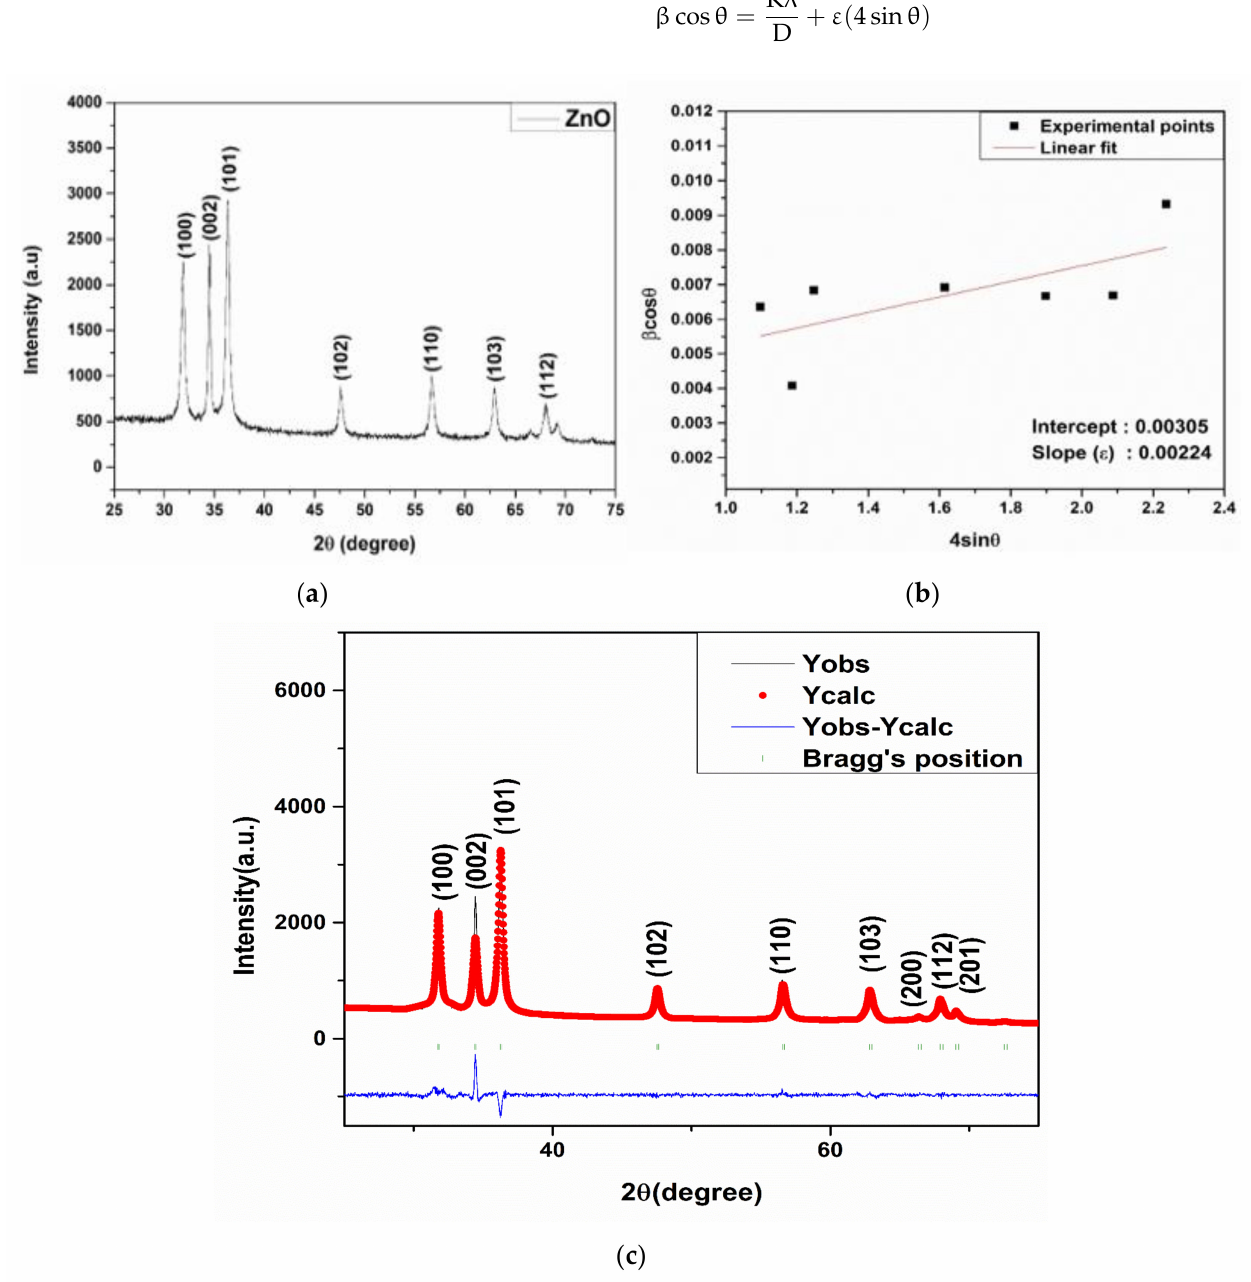
Figure 2. ( a ) XRD pattern, ( b ) W-H plot, and ( c ) Rietveld refined pattern of